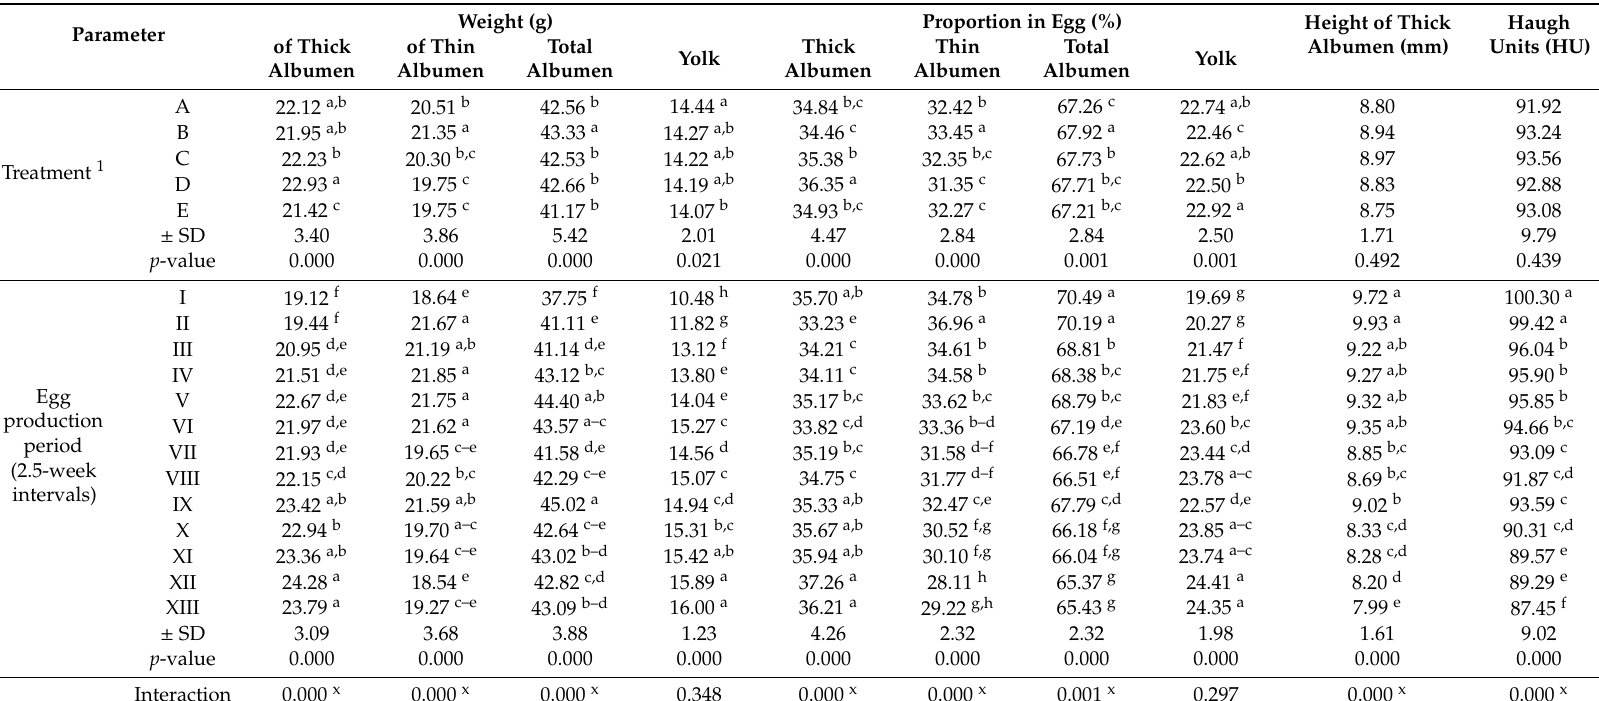
Table 5. Characteristics of egg components (means ± SD